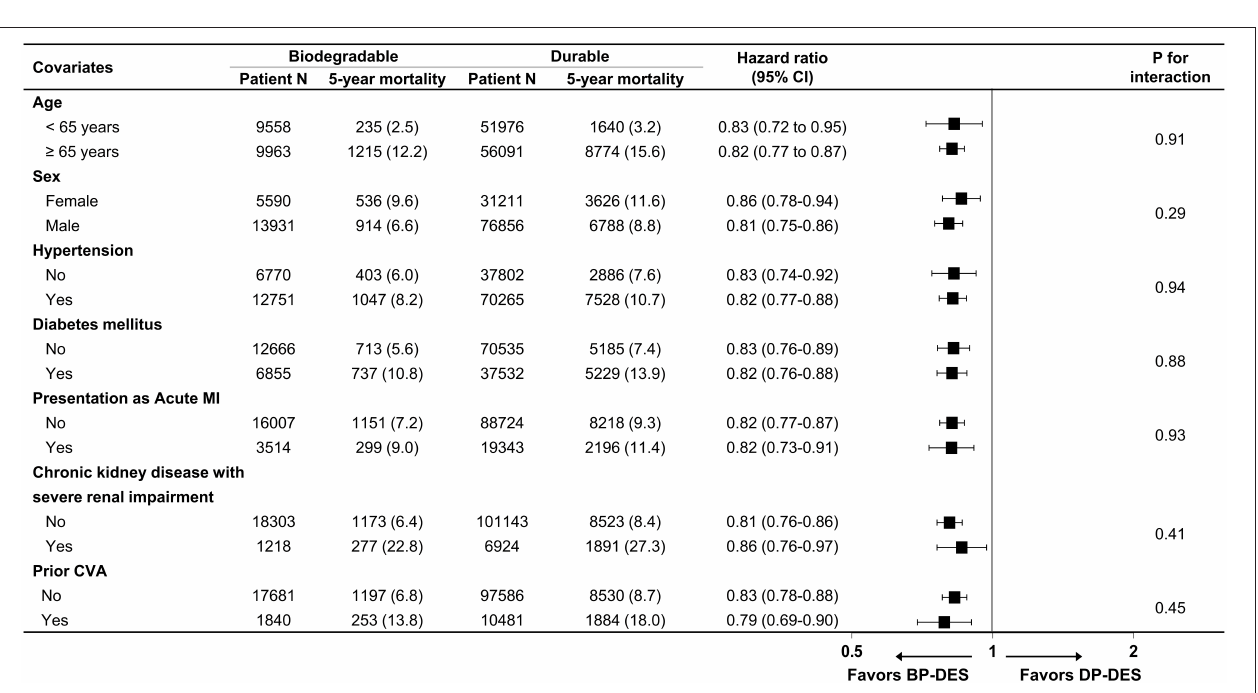
Frontiers in Cardiovascular Medicine |